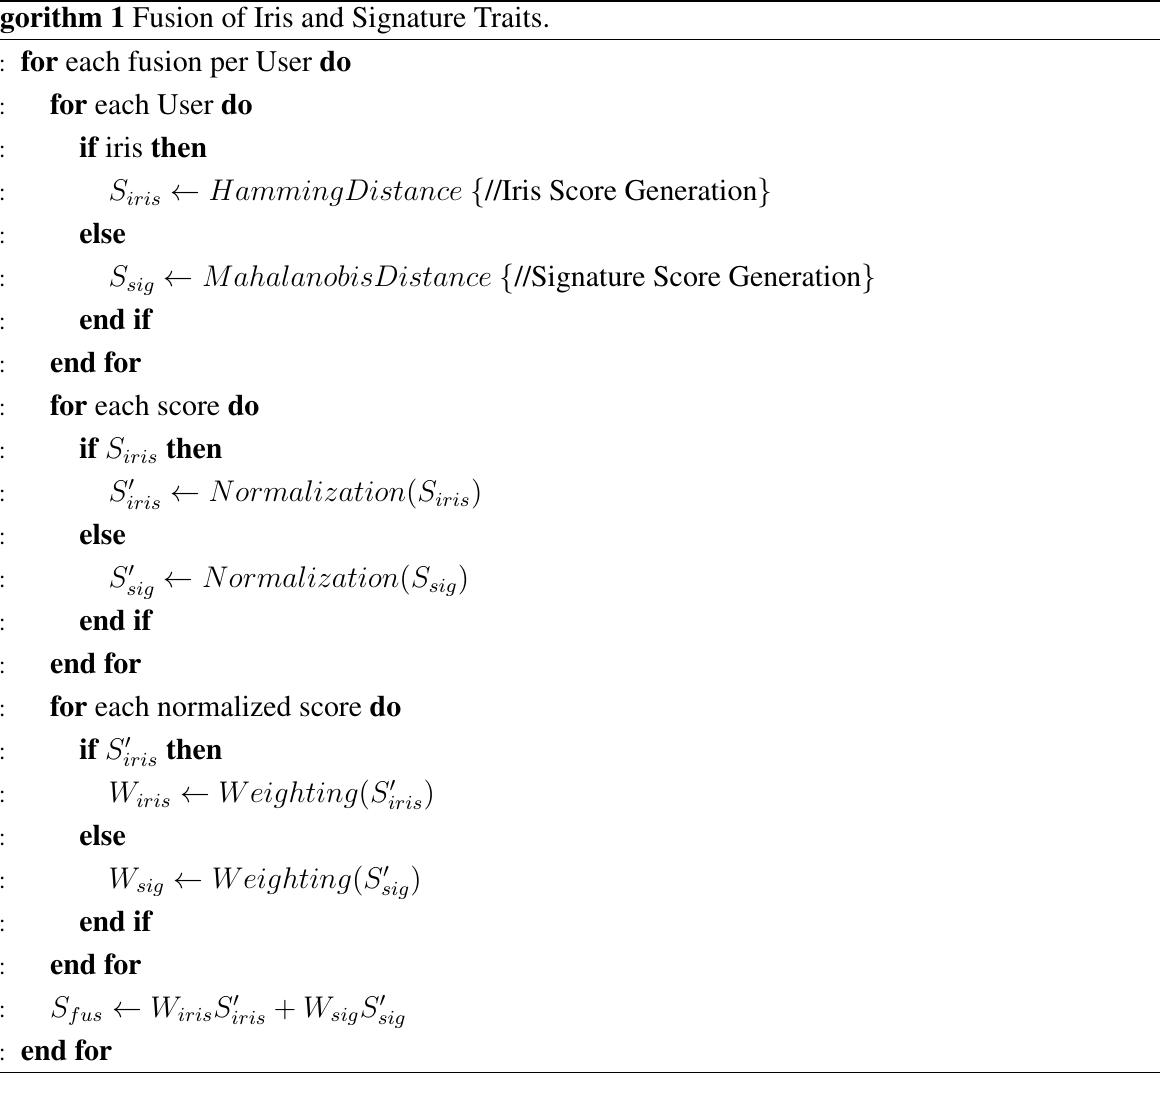
Algorithm 1 Fusion of Iris and Signature